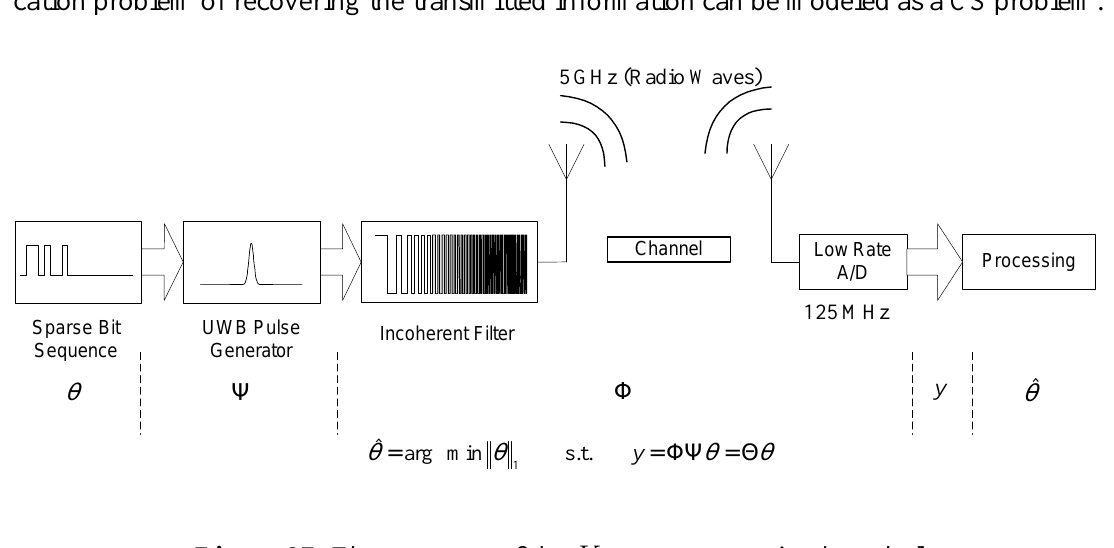
Figure 26. The system architecture of the proposed CS based UWB system. The communi-